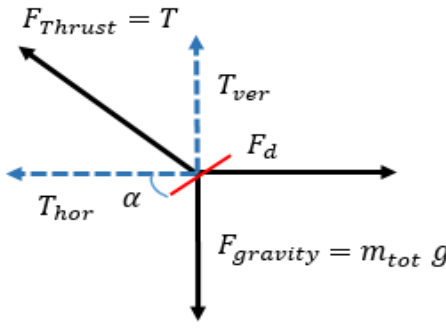
Figure 2. Forces on the MAV during the flight.